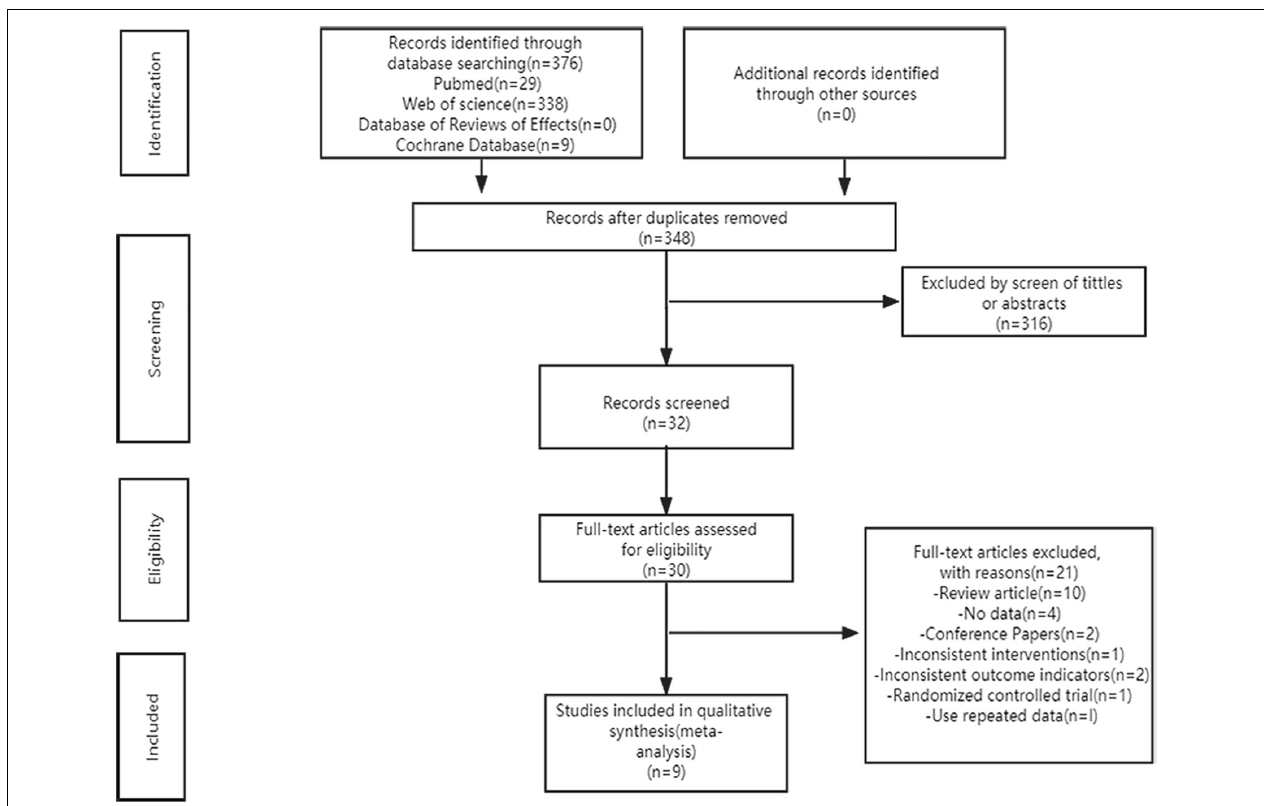
FIGURE 1 | The PRISMA flow diagram of the literature search and study selection.